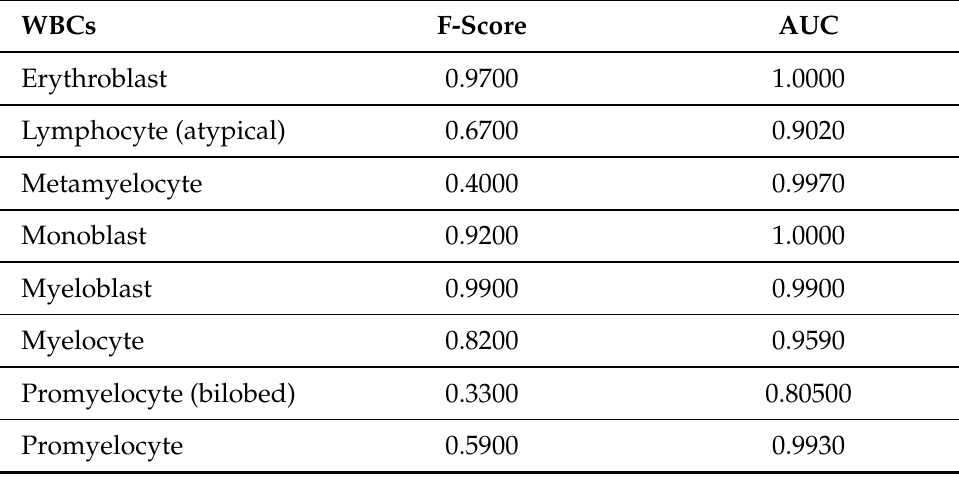
Table 2. F-scores and AUCs for r Stage II DCAE-CNN classification